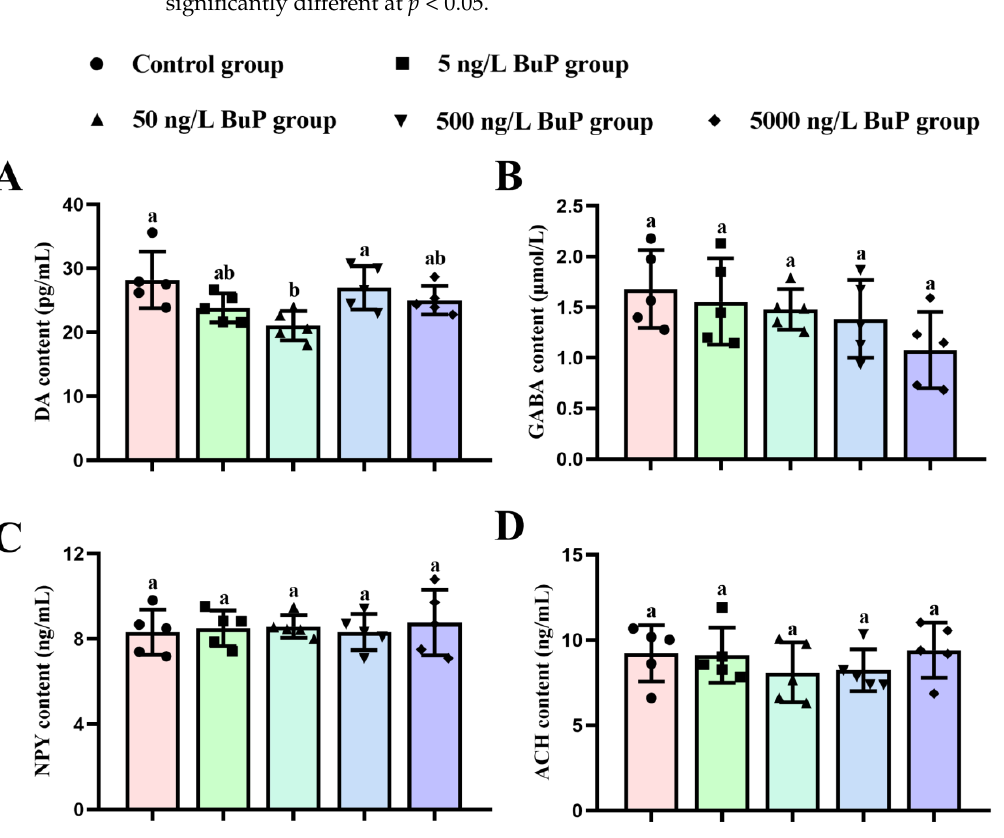
Figure 4. Effects of BuP on the content of DA ( A ), GABA ( B ), NPY ( C ), and ACH ( D ) in the brain tissues. Means of groups not sharing a common letter are significantly different at p < 0.05.